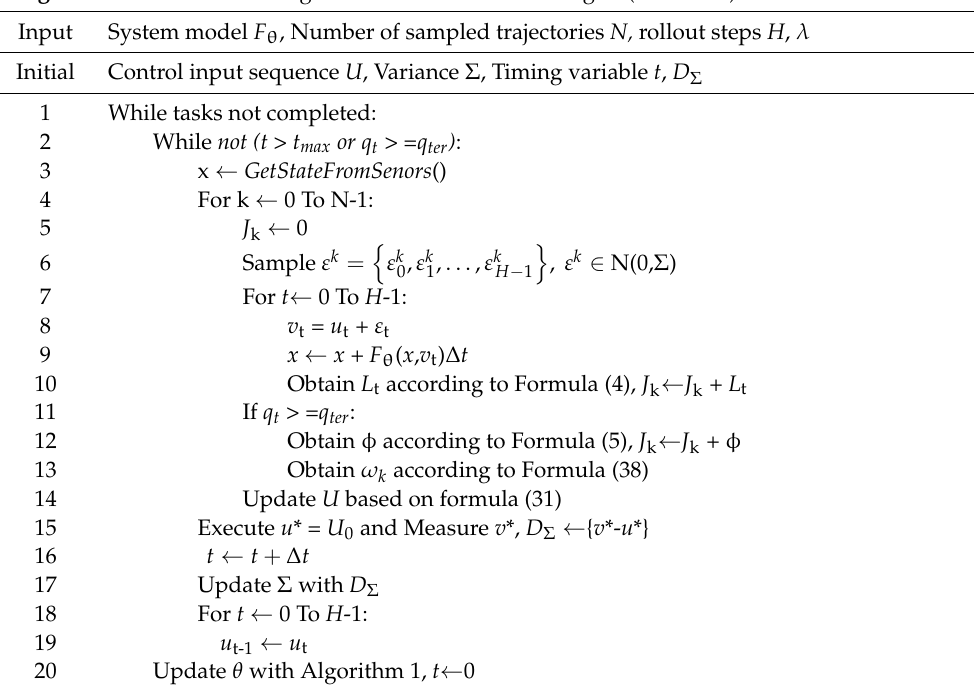
Algorithm 2. Online Learning Model Predictive Path Integral